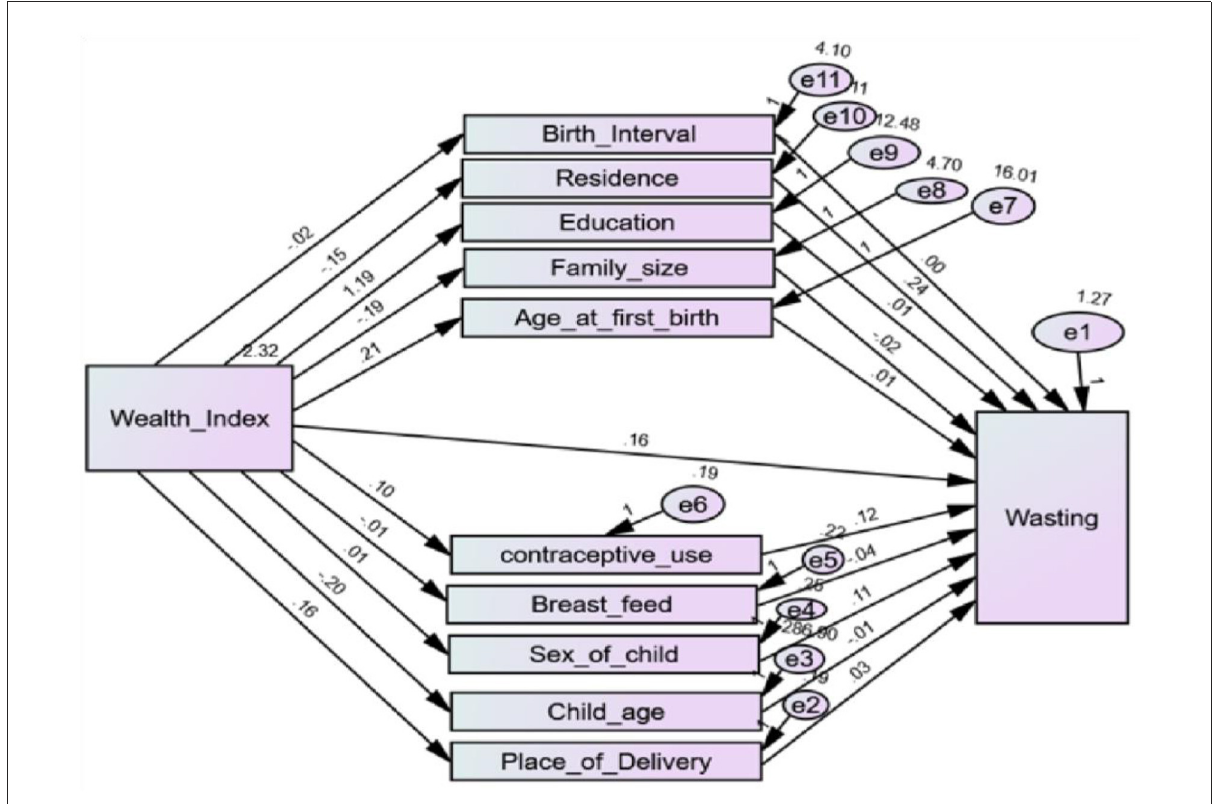
FIGURE5 Path diagram of mediators of the link between the wealth index and wasting.